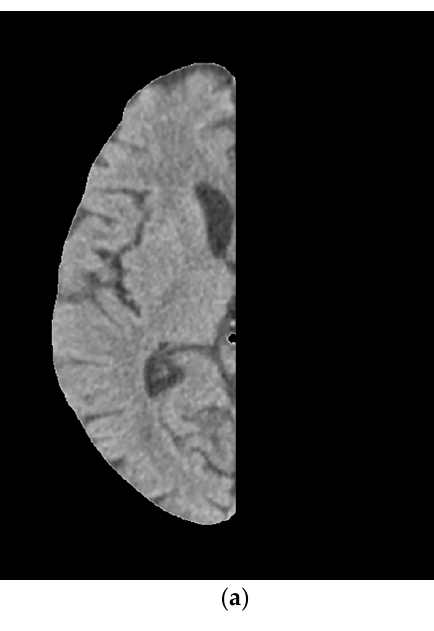
Figure 2. Illustration of comparisons of differences in three orientations used in the Ranklet transformation, including horizontal, vertical, and diagonal